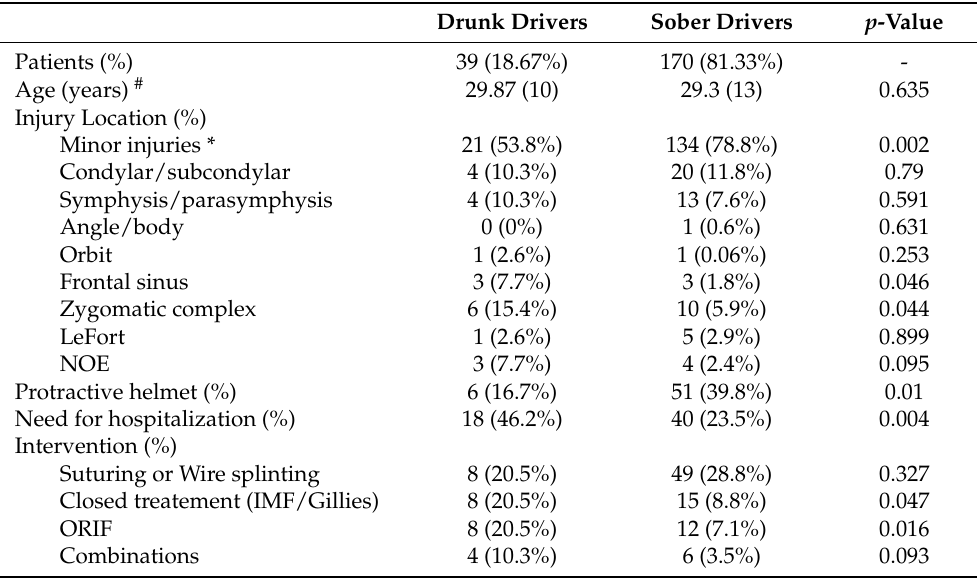
Table 3. Differences between driving under the influence and sober drivers (n = 209 patients). Drunk Drivers Sober Drivers p -Value Patients (%) 39